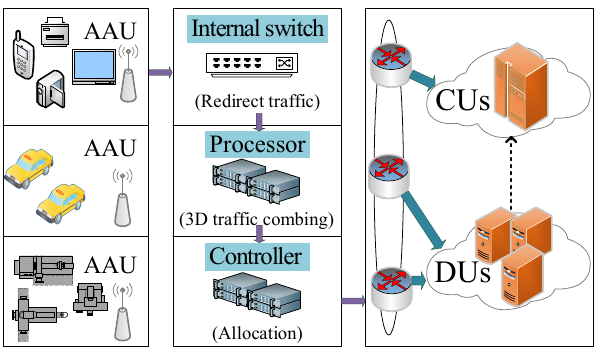
Figure 2. Supporting network structure of the proposed TDTS scheme.